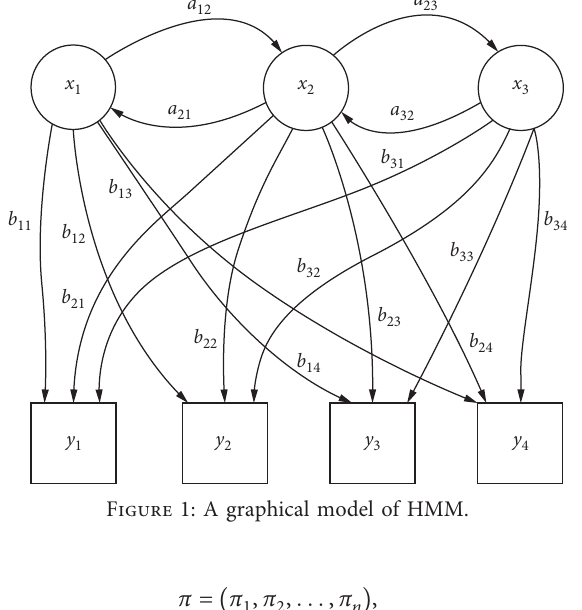
Figure 1: A graphical model of